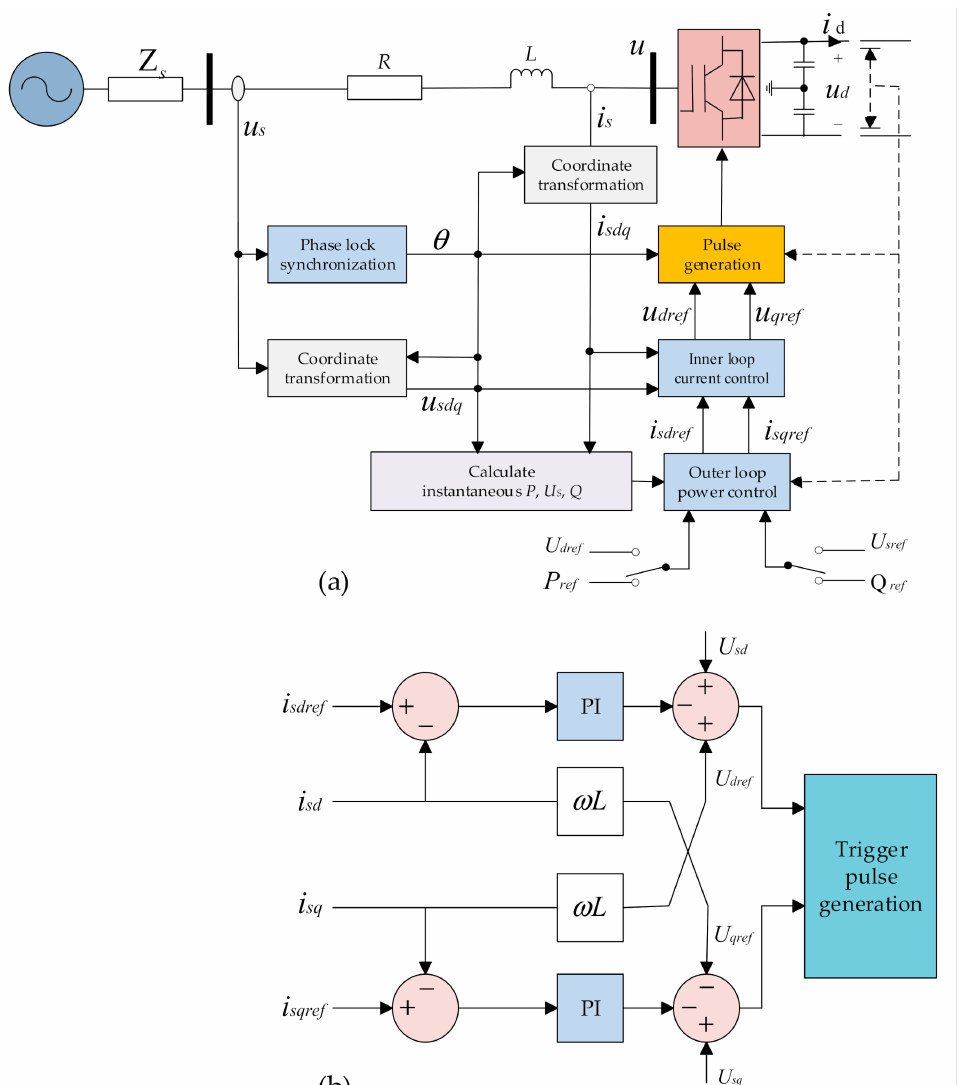
Figure 9. Voltage source converter (VSC) control system structure; ( a ) overall controller structure and ( b ) inner loop controller